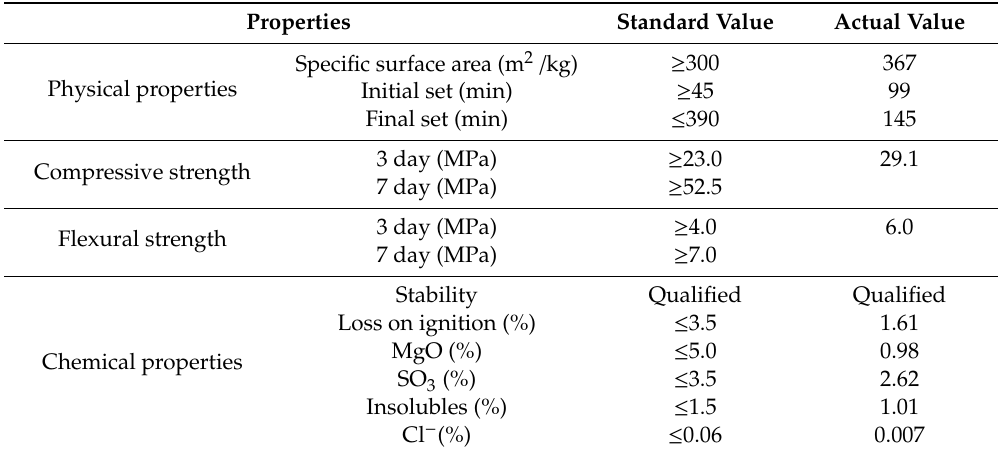
Table 1. Physical and chemical properties of cement.